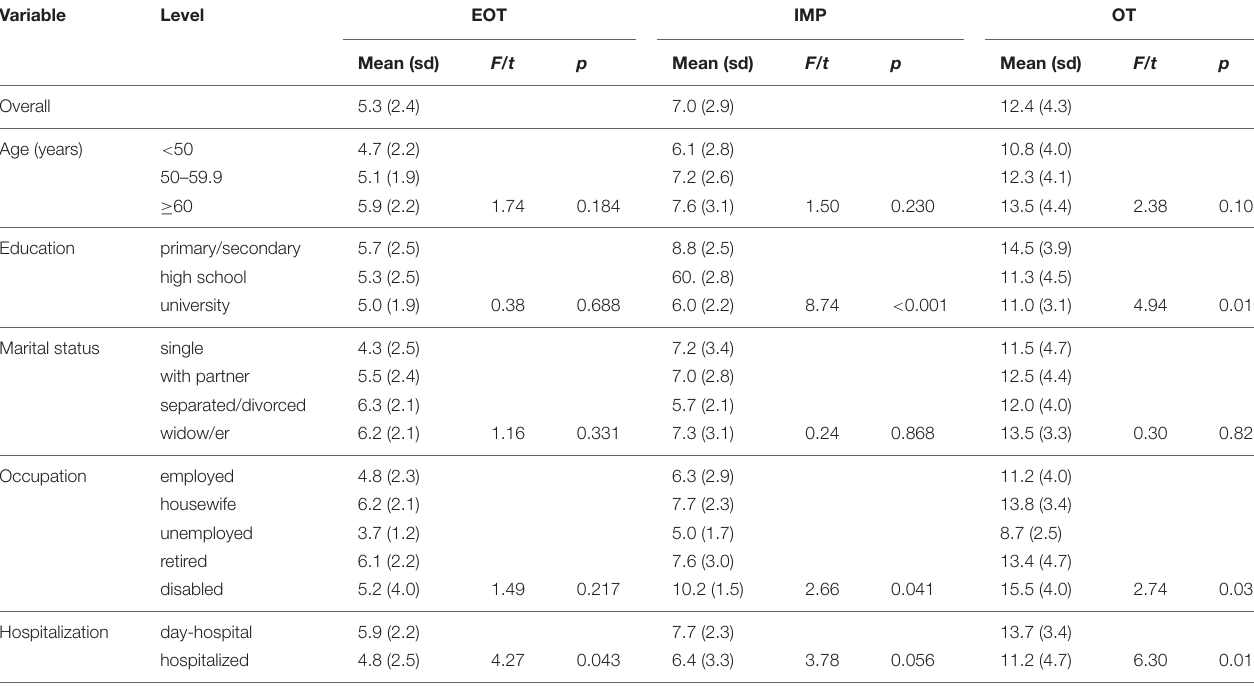
TABLE 4 | Mean values of the TSIA total score and sub-dimensions EOT, IMP, and OT in different subgroups of patients.